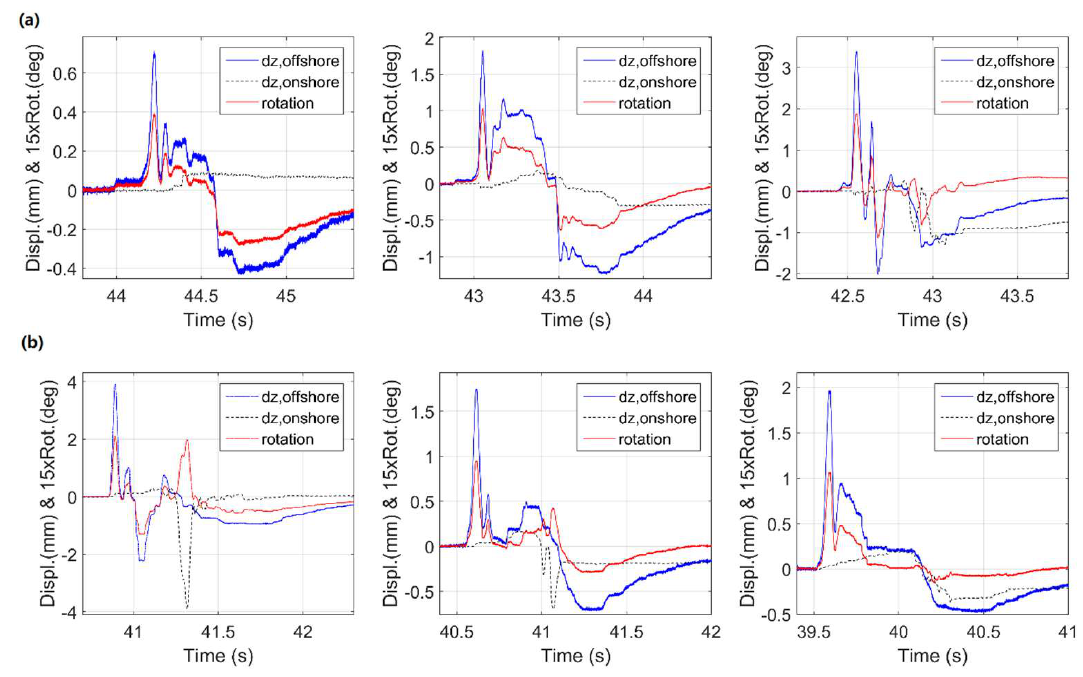
Figure 4. Deck vertical displacements and cumulative rotation for ( a ) solitary waves ( top ) with H = 0.42 m ( left ), H = 0.55 m ( center ), and H = 0.65 m ( right ); and ( b ) bores ( bottom ) with H = 0.90 m ( left ), H = 1.00 m ( center ) and H = 1.30 m ( right ). (dz, o ff shore and dz, onshore = vertical displacement of the o ff shore and onshore lifting lugs